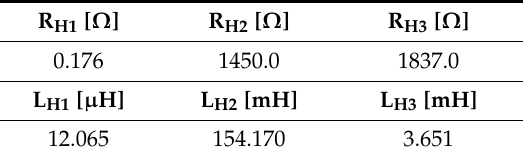
Table 1. The values of resistances and inductances calculated for the Cauer circuit representing the horizontal branches of the transformer equivalent circuit.